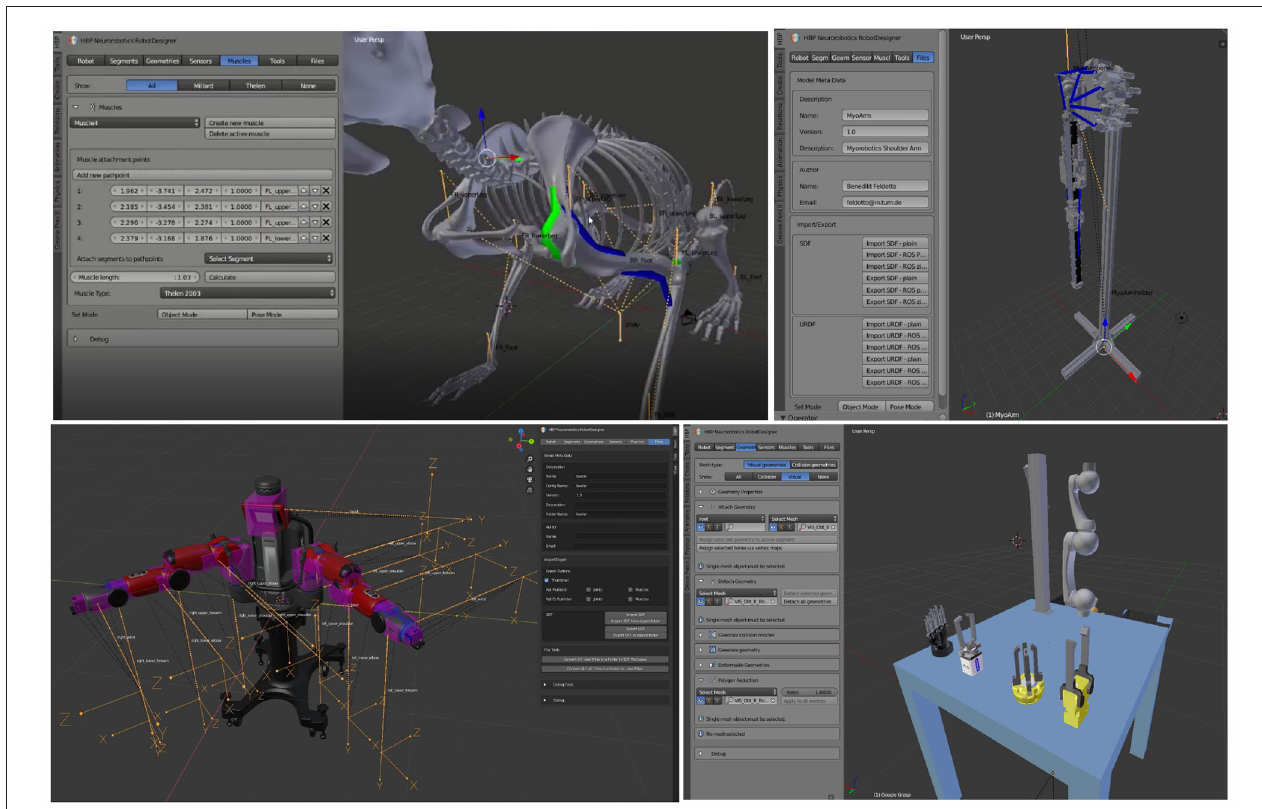
FIGURE 5 | Example Robot Designer models: With the Robot Designer plugin, musculoskeletal models based on biological principles, or biomimetic robots exploiting biological characteristics, as well as classical robot models can be designed. From top left to bottom right: Musculoskeletal rodent model with skeleton and muscles, biomimetic robotic arm built from the modular Myorobotics toolkit with tendon actuators, humanoid robot Baxter, Schunk robotic arm with multiple grippers. In order to simplify the design process, visual cues are used and can be enabled optionally: orange lines indicate the kinematic tree, muscle colors indicate different muscle types, translucent purple boxes visualize the physics inertia. The user interface is kept consistent for Blender 2.7 and 2.8 (Baxter